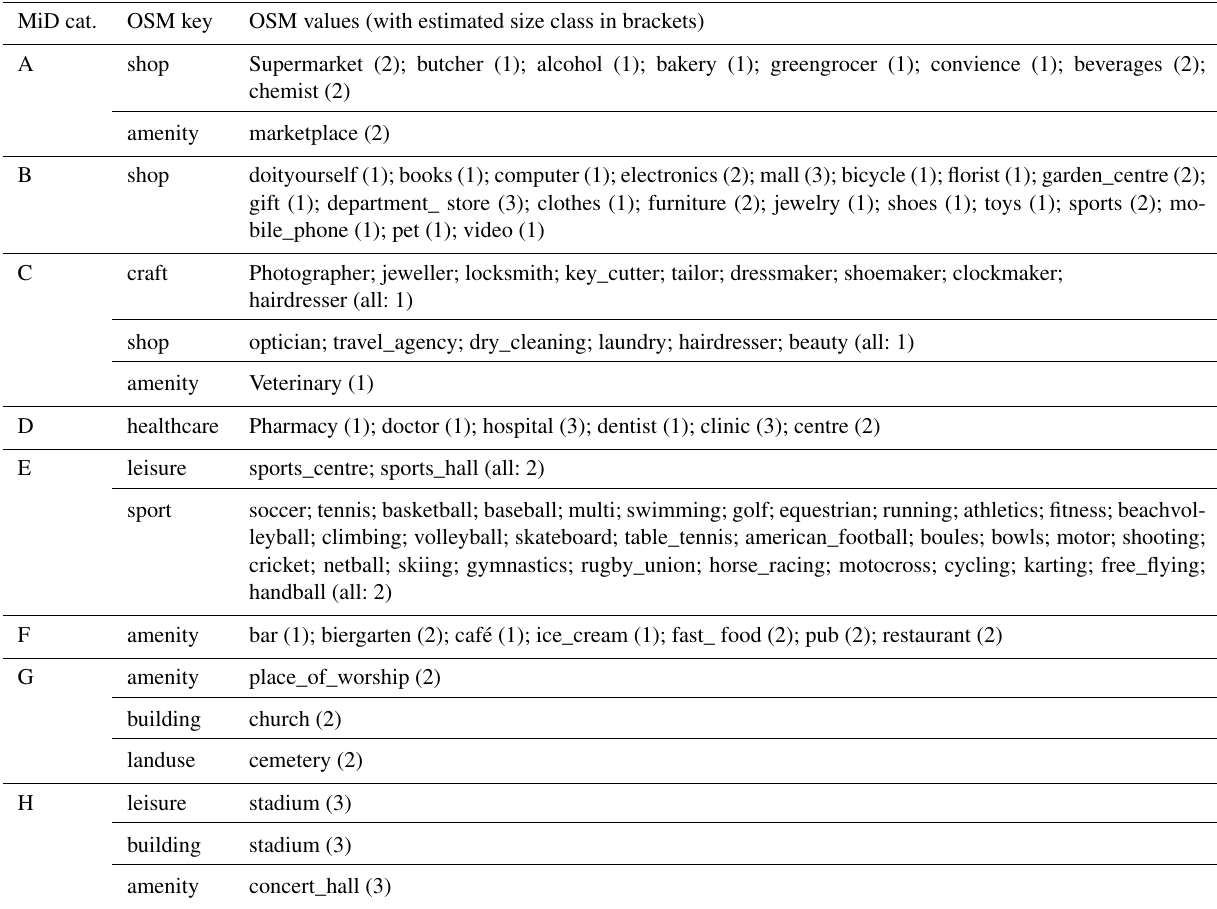
Table A1. Keys and values for POI. MiD cat.